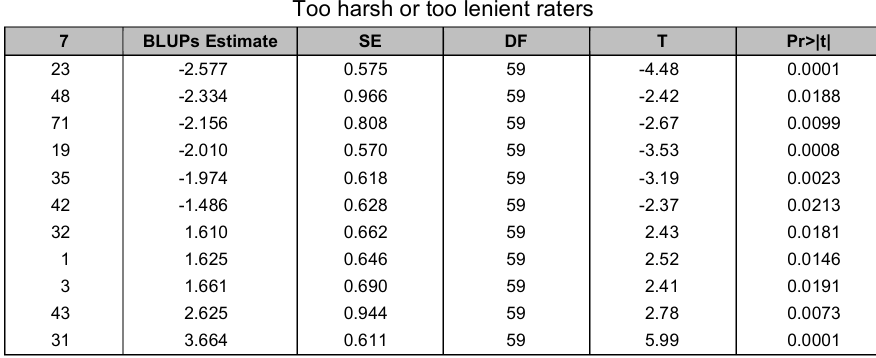
Too harsh or too lenient